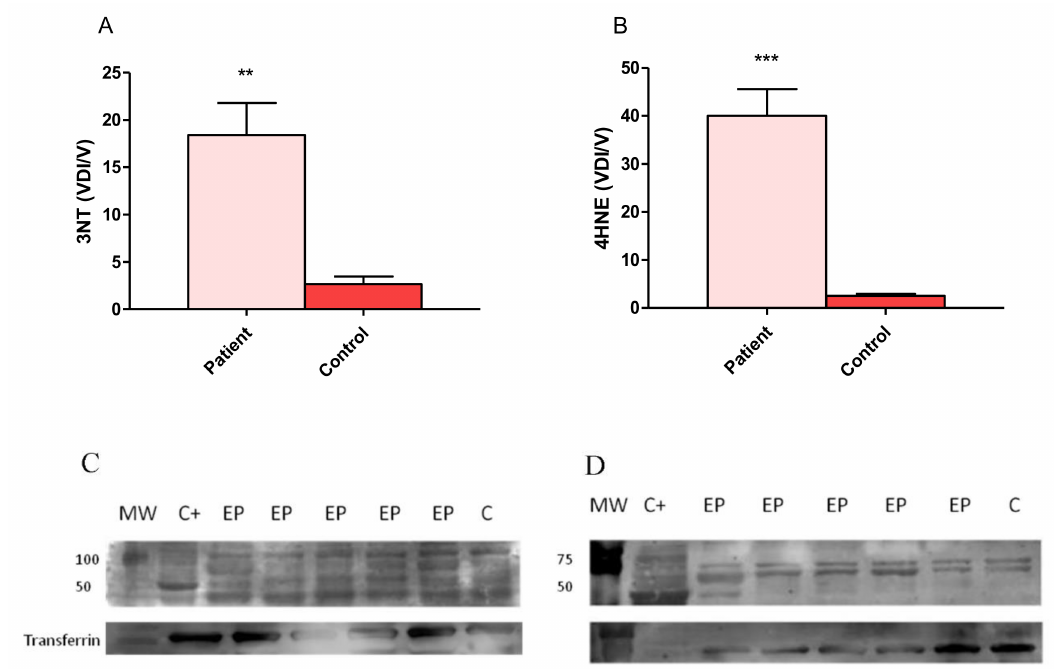
Figure 3. 3-Nitrotyrosine (3-NT) and 4-hydroxy-2-nonenal (4-HNE) expression in patients with drug resistant partial complex seizure. ( A ) Representative example of the blot of 3-NT in a patient and transferrin as a control protein. ( B ) Representative example of the blot of 4-HNE in a patient and transferrin and controls. ( C ) Comparison of relative optical density values of 3-NT in patients and control subjects. ( D ) Comparison of relative optical density values of 4-HNE in patients and control subjects. The bars represent the means ± the standard errors of the mean, unpaired t-Student test, ** p ≤ 0.003, *** p ≤ 0.0001. C+ rat protein extract was used as the positive control in both blots. MW; molecular weight, EP; epileptic patient, C;